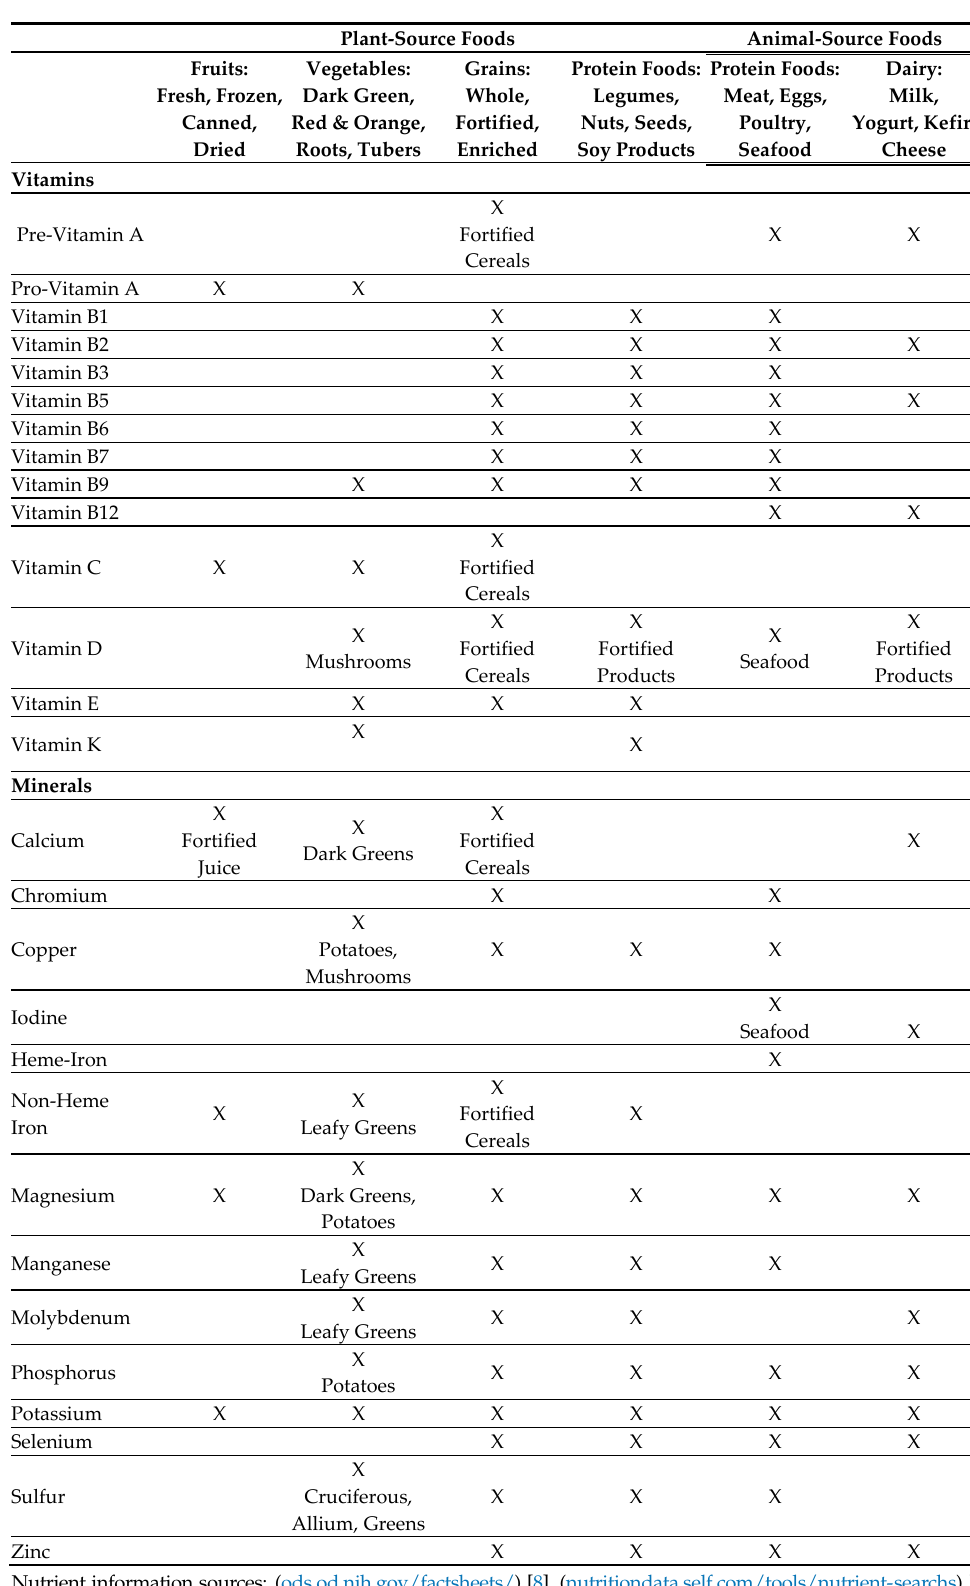
Table 2. Micronutrients Commonly Associated with Plant-Source and Animal-Source Foods.